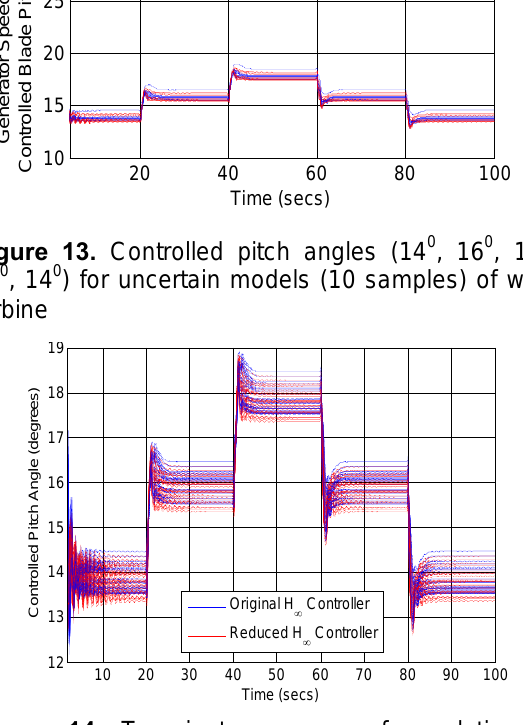
Figure 14. Transient response of regulation of generator speed (maintained constant at 42 rpm) for varied pitch angle in steps (14 0 , 16 0 , 18 0 , 16 0 , 14 0